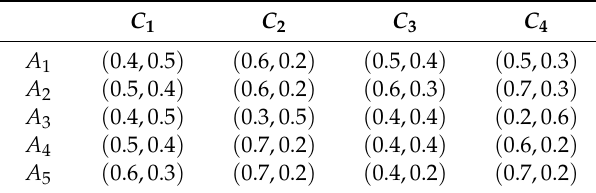
Table 10. The original fuzzy decision matrix A 2 given by D 2.